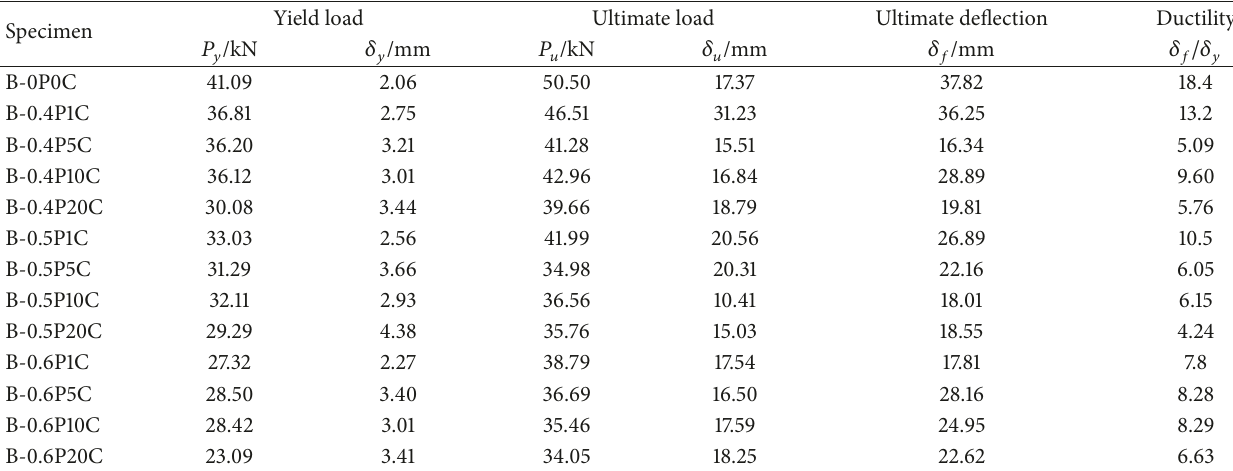
Figure 11: Average chloride diffusion coefficient in crack region. Black circles refer to average chloride diffusion coefficients. Solid lines refer to linear regression. Table 3: Testing results of beam specimens under monotonic